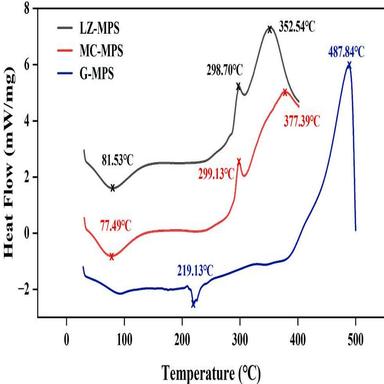
DSC curves of LZ-MPS, MC-MPS, and G-MPS.